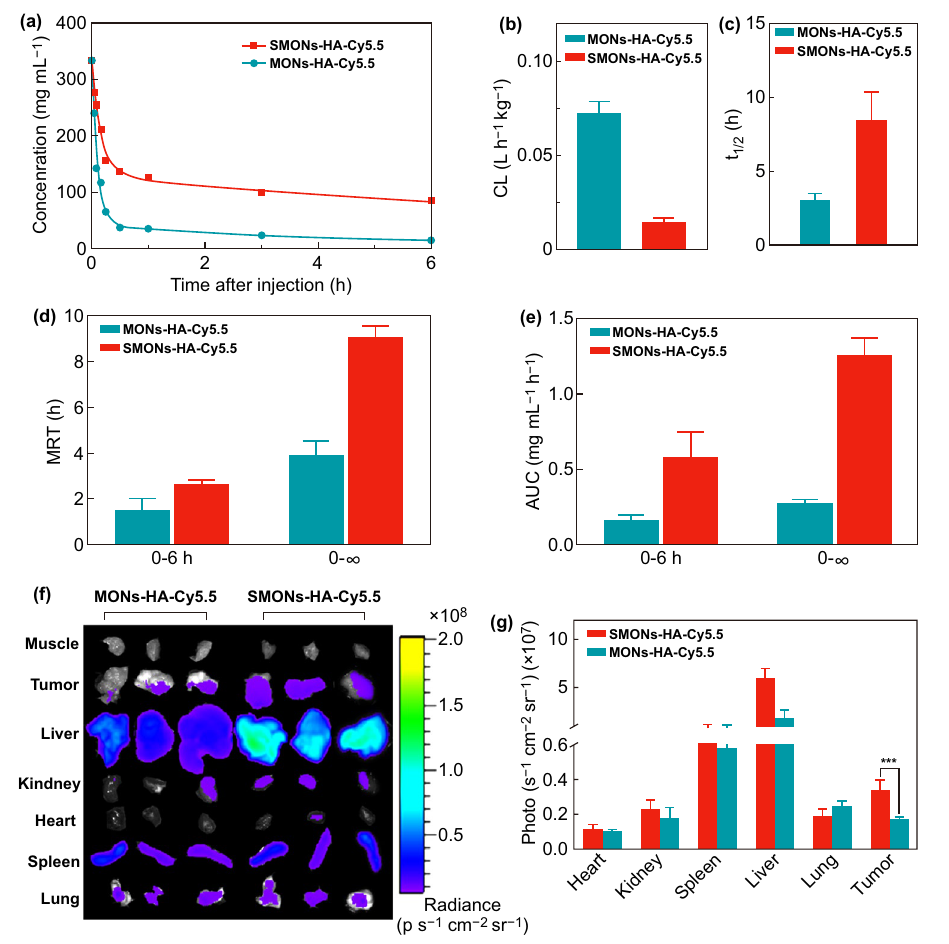
Fig. 4 Blood circulation and tumor accumulation. a Concentrations of Si in the blood at different time intervals after injection of MONs-HA- Cy5.5 and SMONs-HA-Cy5.5. b The corresponding clearance (CL), c the terminal phase half-life( t 1/2 ), d the mean residence time (MRT) and e blood concentration versus time curve (AUC) of MONs-HA-Cy5.5 and SMONs-HA-Cy5.5 by fitting the circulation profile. f Near-infrared fluorescence (NIFR) imaging and g quantification of the fluorescence intensity in the major organ and tumor from MCF-7 bearing mice ( n = 3) at post-24 h after the administration of the SMONs-HA-Cy5.5 or MONs-HA-Cy5.5. *** P <